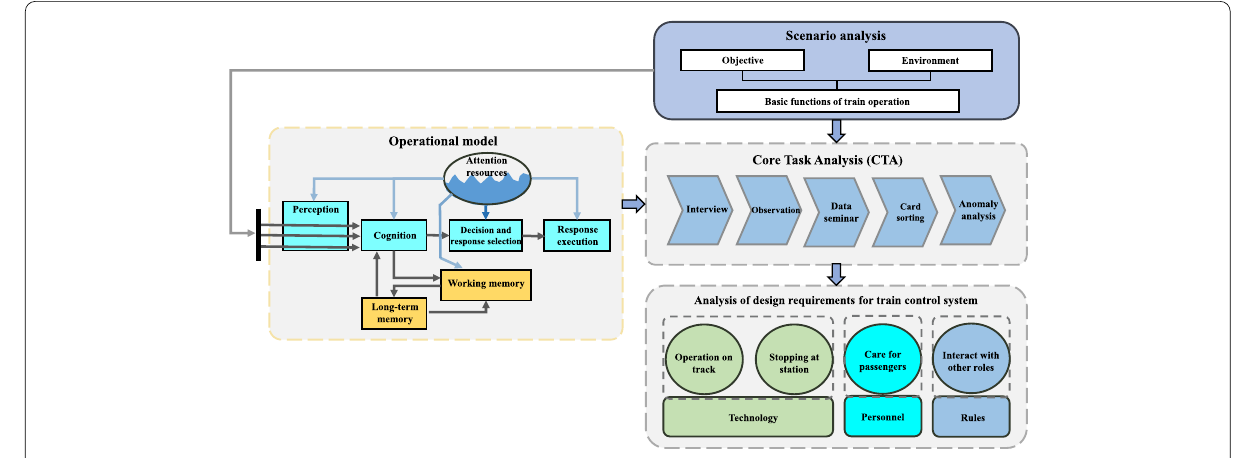
Figure 3 System design requirements analysis framework based on human factor